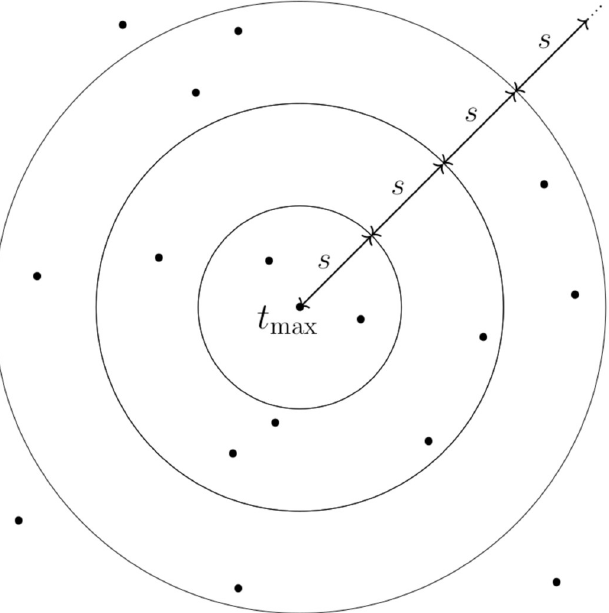
Fig 3. A schematic of our clustering procedure in Algorithm 1. Each point is a TCR portrayed in an abstract 2-D space, where the distance between points is determined by TCRdist. Our procedure starts by identifying the maximally lonely TCR t max according to Eq (10). In each iteration, we step out s units of TCRdist, and compute the mean loneliness of all TCRs within the annulus defined by the current and previous radii (or ball in the first step). By construction of Eq (10), we expect the loneliness values to steadily decrease as we move away from t max , until we arrive at a radius where the loneliness values have stabilized. This “breakpoint radius” thus defines the radius of our cluster.